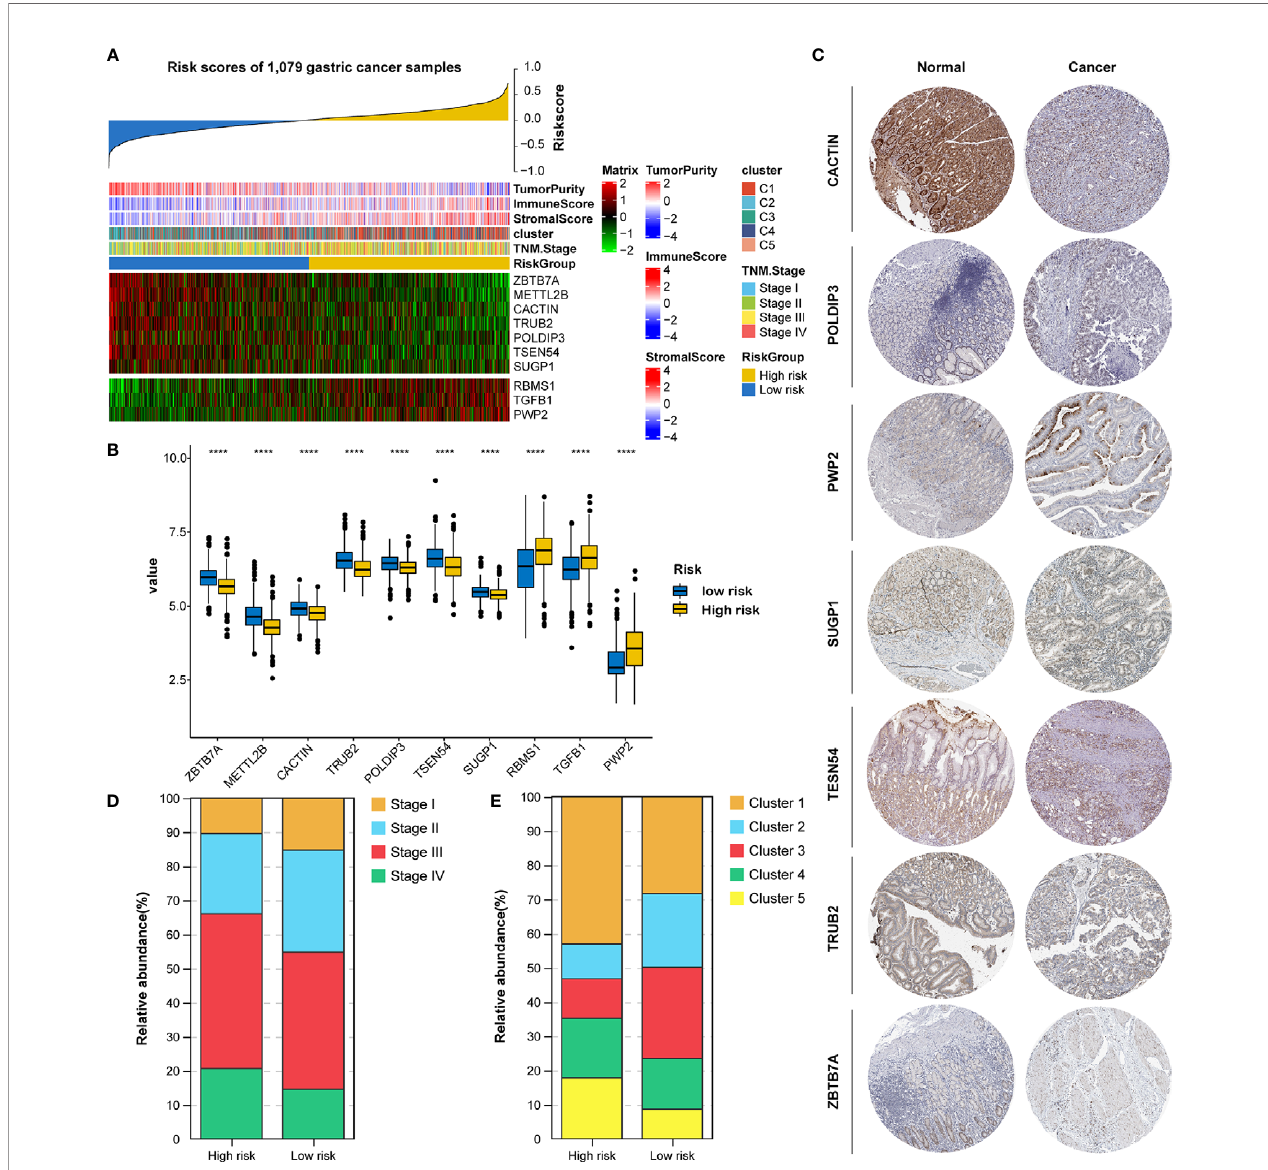
FIGURE 5 | Identi fi cation of expression and clinical features underlying the RNA processing-related prognostic signature. (A) Heatmap showing the expression patterns of 10 prognosis-associated RNA processing factors for the entire 1079-sample GC set sorted by the signature risk score in ascending order. (B) Differential expression of the 10 prognosis-associated RNA processing factors between the low-risk and high-risk groups. P values were obtained by the Mann-Whitney test. The asterisks represented the statistical P-value (****P < 0.0001). (C) Histogram showing the distribution of TNM stage between the low-risk and high-risk groups. (D) Histogram showing the distribution of the fi ve distinct RNA processing patterns between the low-risk and high-risk groups. (E) Immunohistochemical analysis of the protein expression of the 7 prognosis-associated RNA processing factors in the HPA